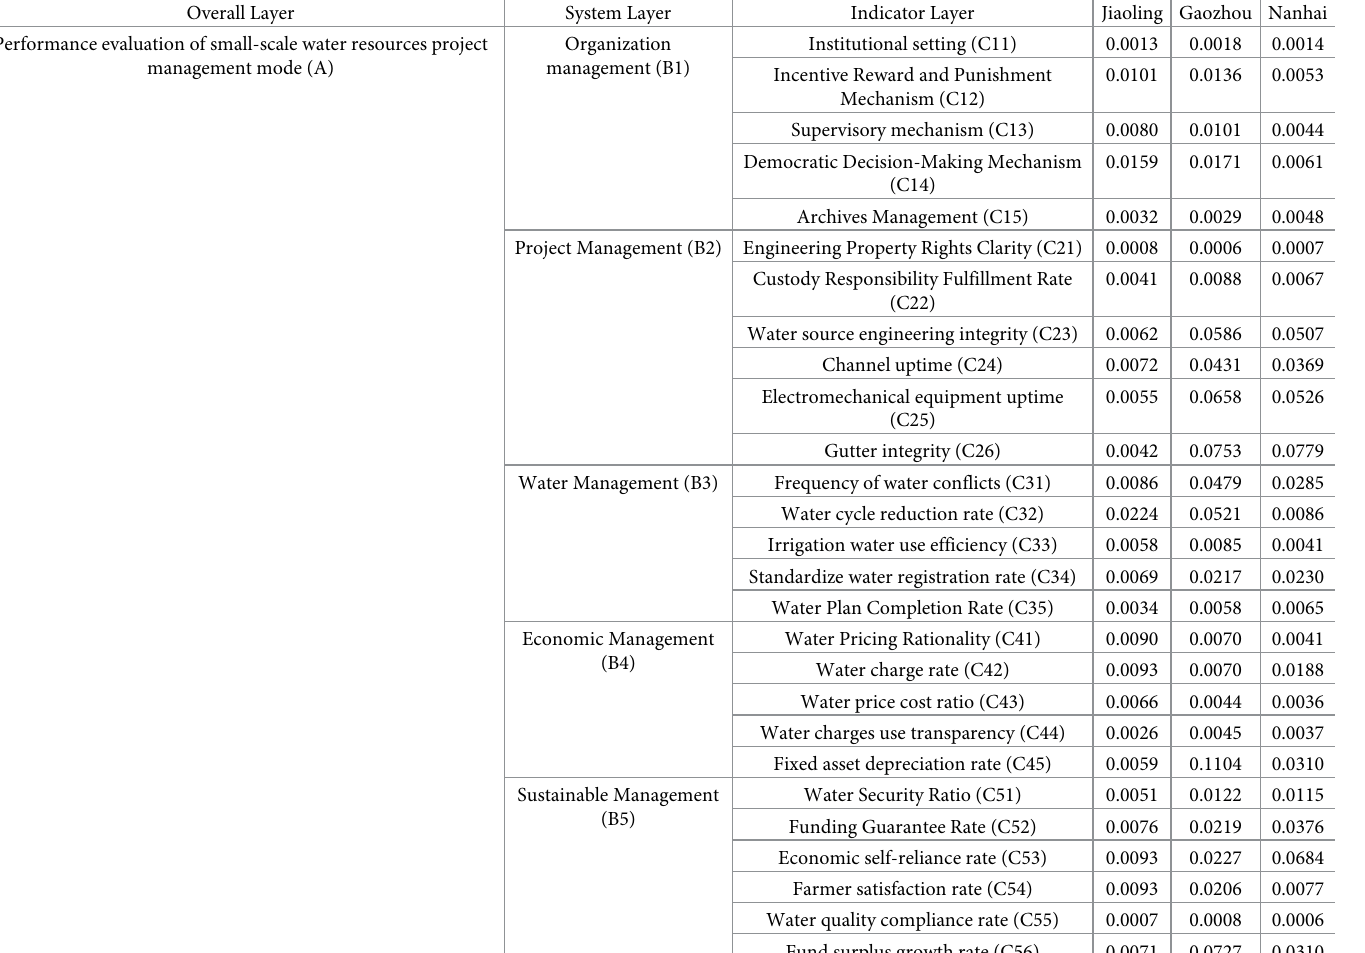
Table 4. Weighted normalized evaluation matrix based on entropy weight method and